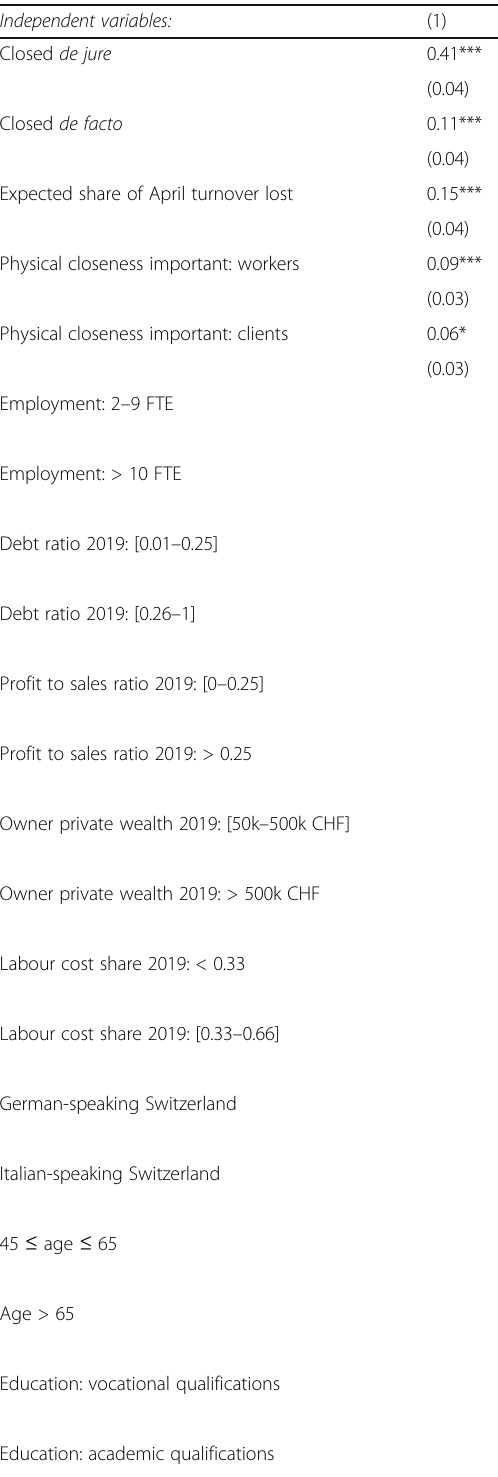
Table 3 Determinants of the use of income